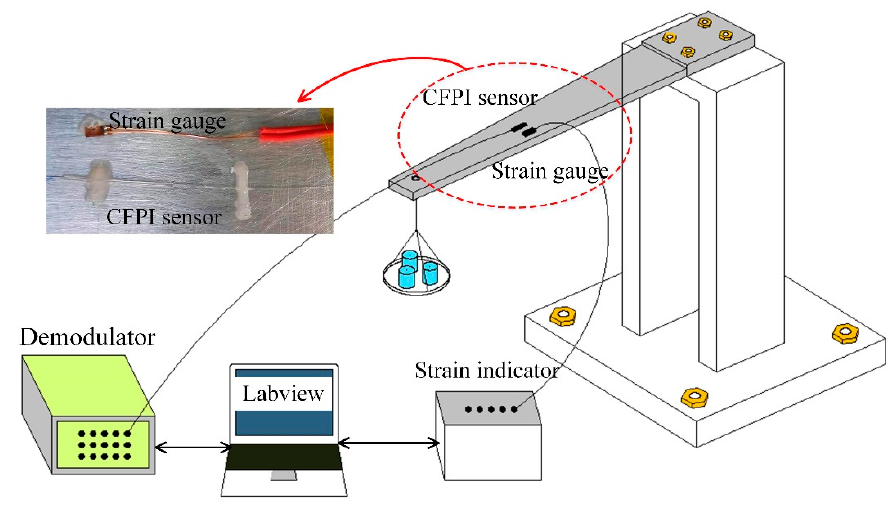
Figure 7. Schematic diagram of static strain measurement and calibration at room temperature.